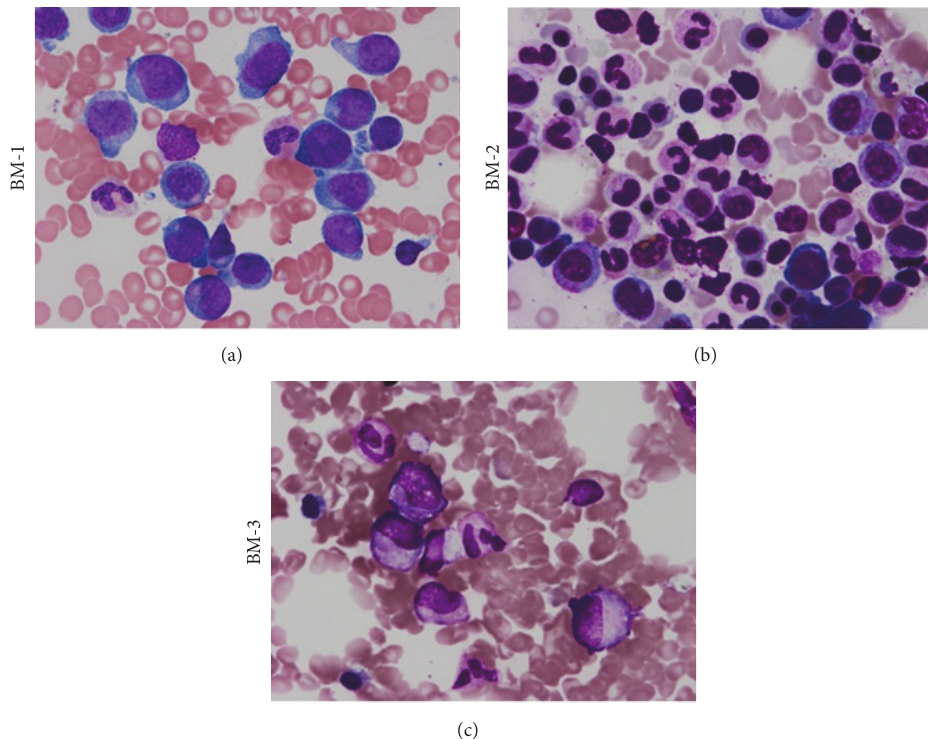
Figure 1: Bone marrow morphology. (a) At time of first detected disease relapse (BM-1); (b) first detection of spontaneous remission (BM-2); (c) second detection of spontaneous remission (BM-3). All marrow aspirate slides were photographed at magnification ×